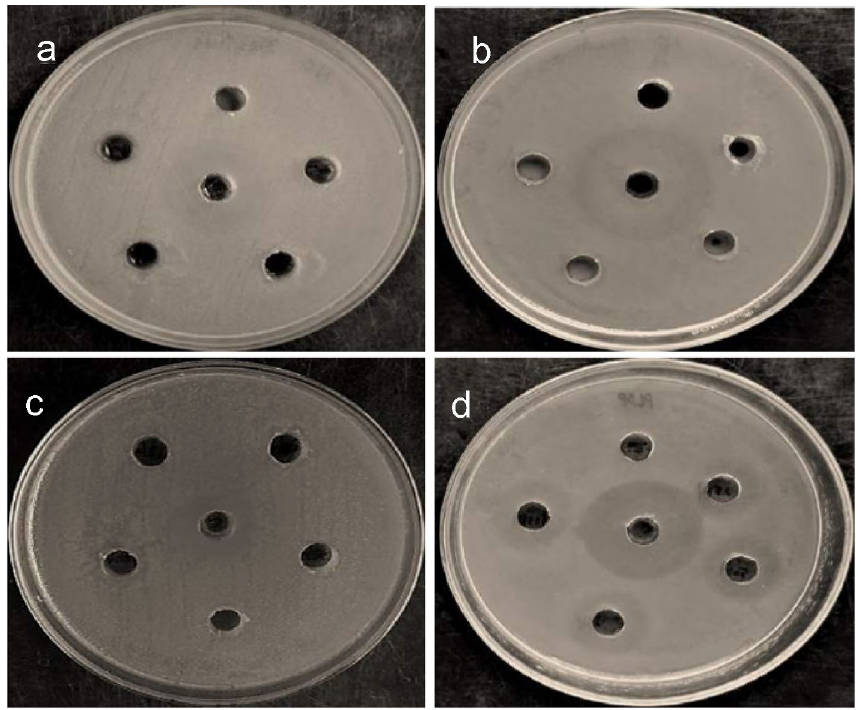
Figure 11. Antibacterial activity of ( a ) Latex coated SPIONs against Bacillus subtilis, ( b ) Latex coated SPIONs against Pseudomonas aeruginosa, ( c ) drug loaded nanoconjugate against Bacillus subtilis, ( d ) Pseudomonas aeruginosa.